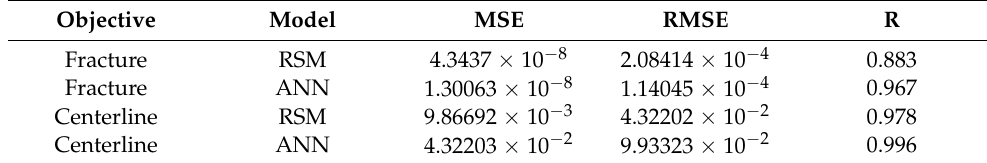
Table 4. Statistical features of surrogate models.